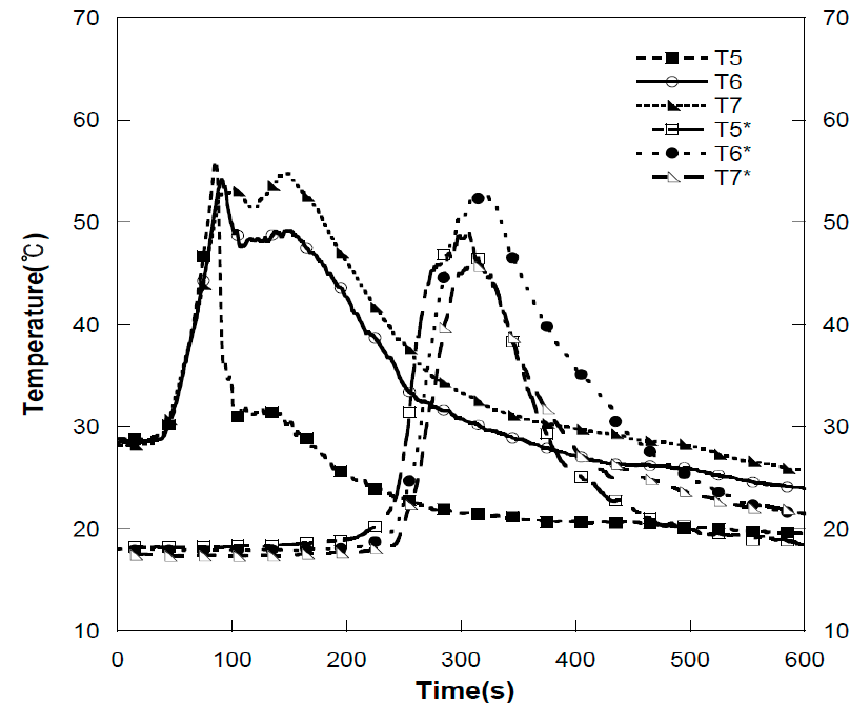
Figure 11. Comparison of the average heat air current temperatures around the stream of breath in the fire tests of the fuel packages for residential spaces and multiplexes (*: fuel package for multi- plexes). Table 3. Maximum temperatures by thermocouple position in the fire tests of the fuel packages for residential spaces and multiplexes.